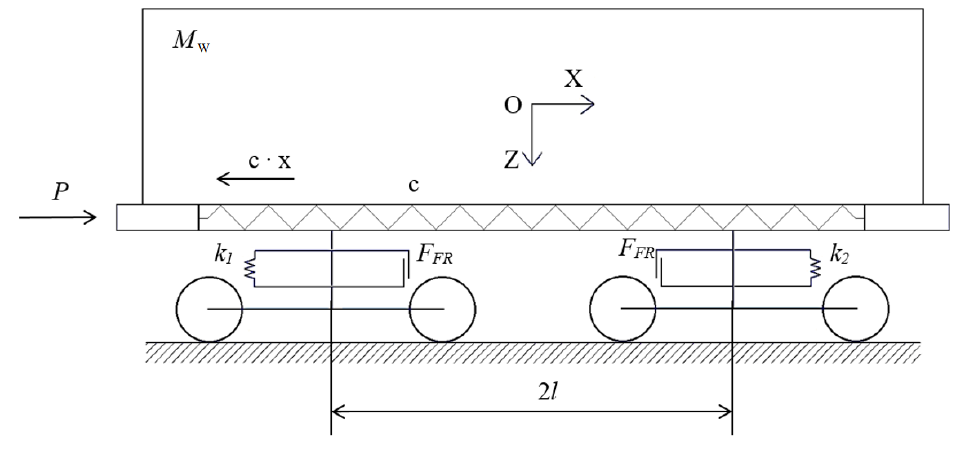
Figure 1. Carrying structure of the circular tube open wagon with aluminum foam as filler for cen- ter sill.